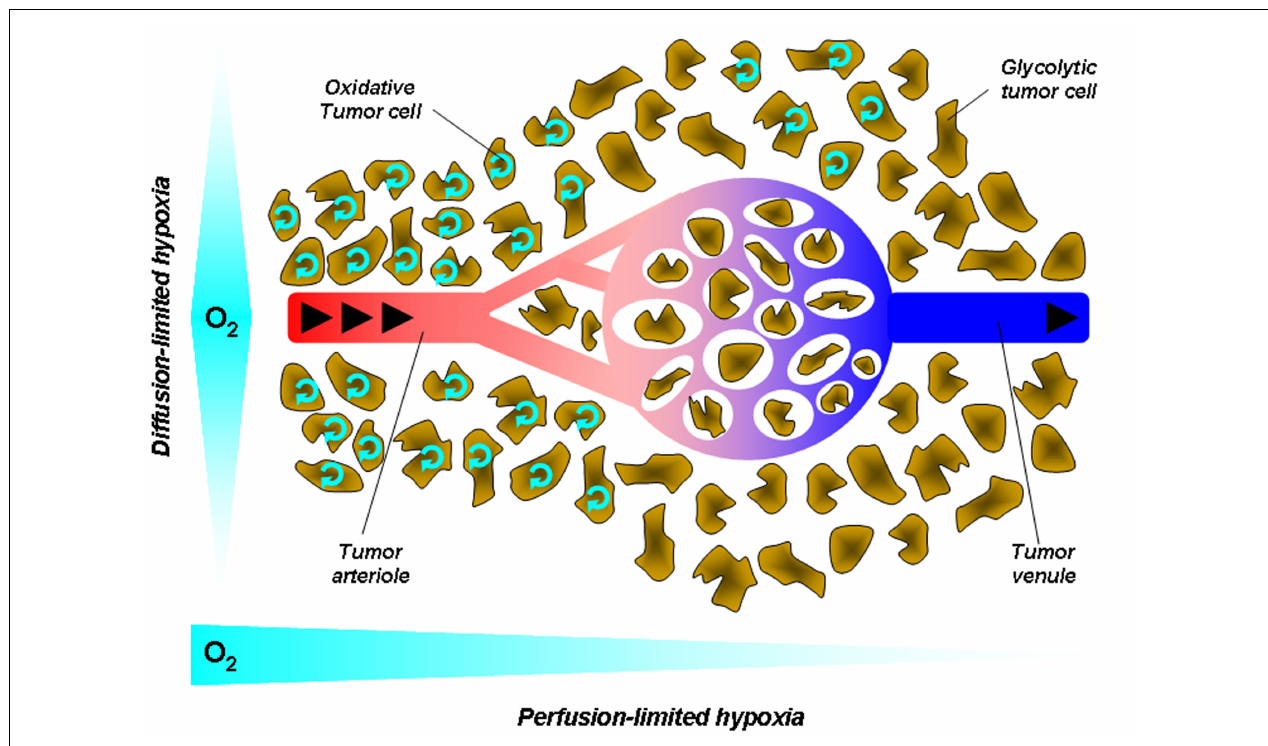
a loosened vascular network. Perfusion-limited hypoxia refers to oxygen deprivation along the vascular tree from the tumor margin toward the tumor core. Poor oxygen delivery has many causes in tumors, including high-rate of oxygen extraction at the tumor margin, decreased red blood cell deformability, and stacking, increased blood viscosity due to water extraction, vascular disorganization, and angiogenesis. Arrows represent the blood